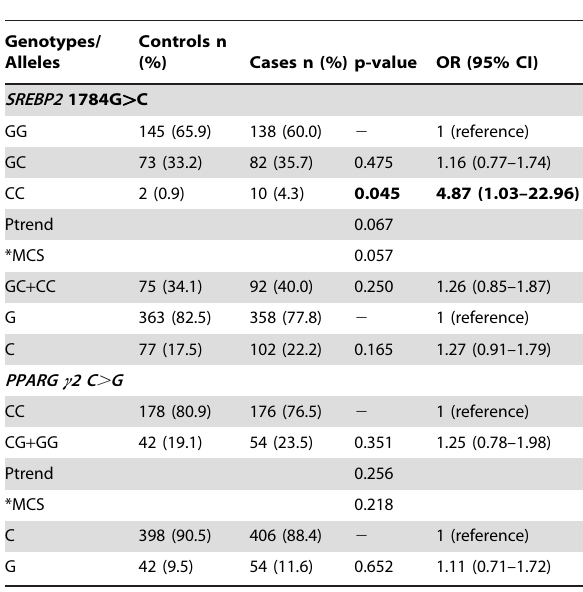
Table 4. Adipogenesis differentiation